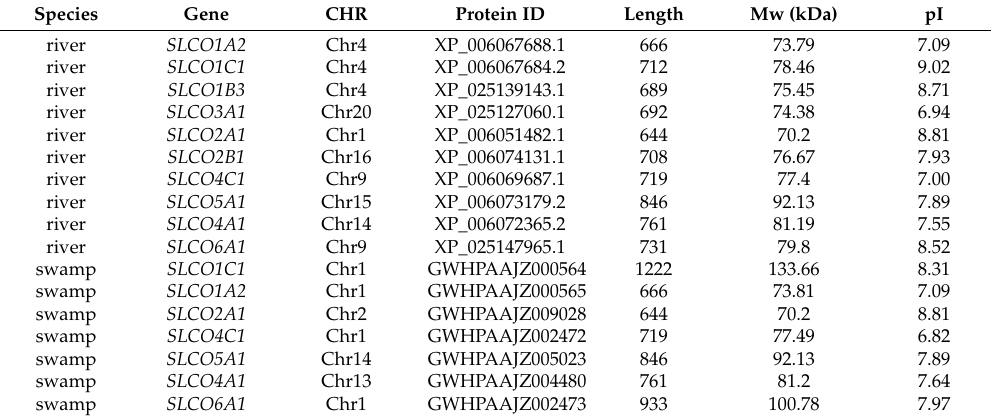
Table 1. Features of the predicted OAT protein sequences in